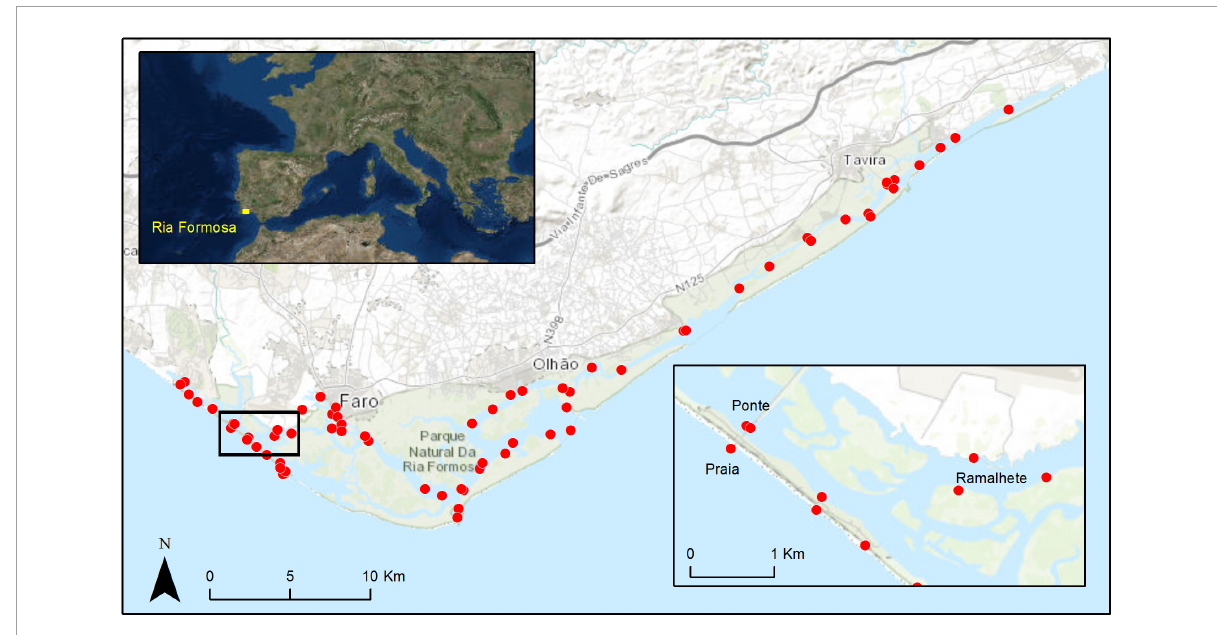
FIGURE1 Map of the Ria Formosa lagoon, Portugal showing the main sampling stations. Inset _top left: geographical location of the lagoon; inset_bottom right: expansion of the rectangle at the western lagoon showing more intensively sampled stations, particularly Praia, Ponte and Ramalhete for the Water Framework Directive